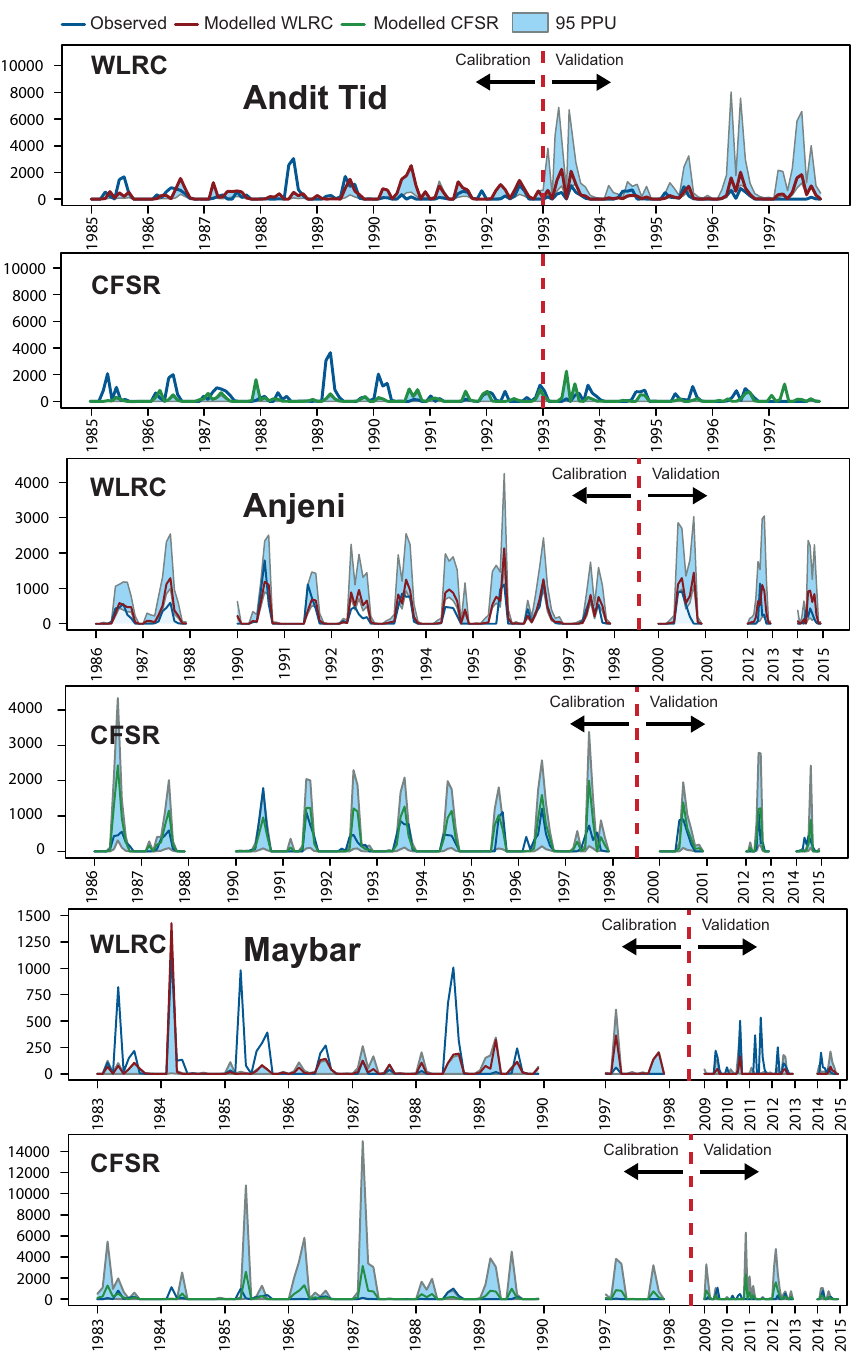
Figure 4. Modelled SWAT soil loss compared to measured soil loss (blue) for WLRC (red) and CFSR (green) input data and 95% prediction uncertainty (light blue). Each sub-figure contains the calibration and the validation period. Results are given in tons per month (tmonth − 1 ).